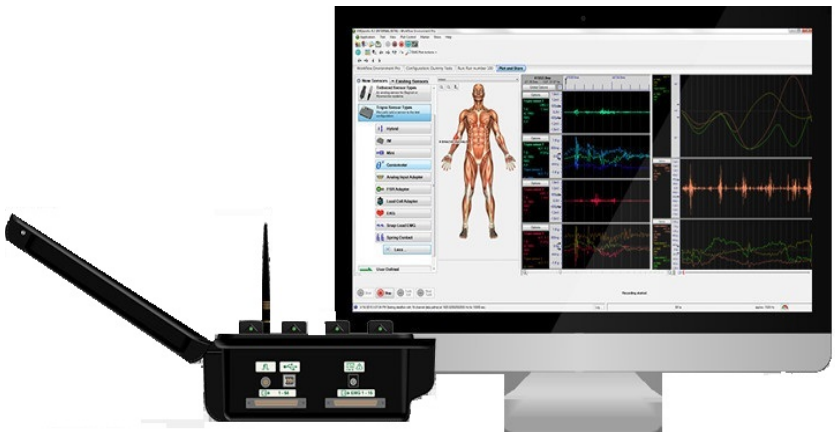
Figure 1. Trigno wireless electromyography (EMG) acquisition system.